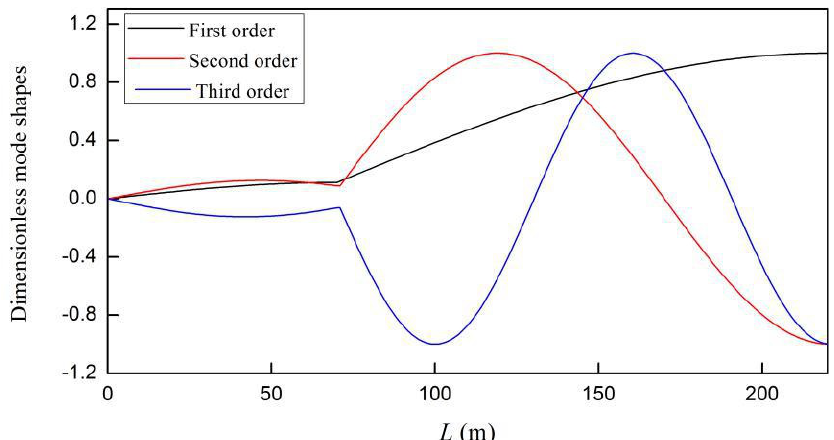
Figure 12. Mode shapes of first-three orders.